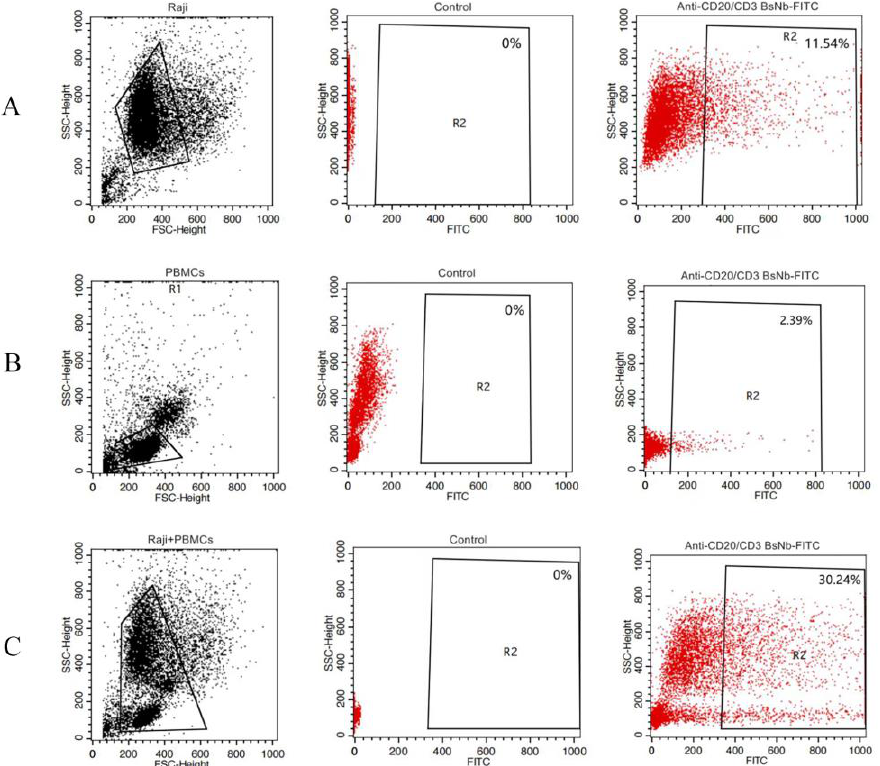
Figure 7. Flow cytometry analysis of the binding activity of anti-CD20/CD3 BsNb. FITC-labeled anti-CD20/CD3 BsNb at a final concentration of 100 µ g/mL was added to the CD20-expressing lymphoma cell line Raji, CD3-expressing human PBMCs, as well as Raji and PBMCs, mixed with the same number of cells as the experimental group, and PBS was added to cells as a negative control for the flow cytometry analysis. Binding of anti-CD20/CD3 BsNb to Raji cells ( A ), binding to freshly isolated PBMCs ( B ), and binding to a mixed group of Raji and PBMCs ( C ) were displayed, respectively. The results indicate that the purified anti-CD20/CD3 BsNb antibody could simultaneously bind to Raji cells and PBMCs.